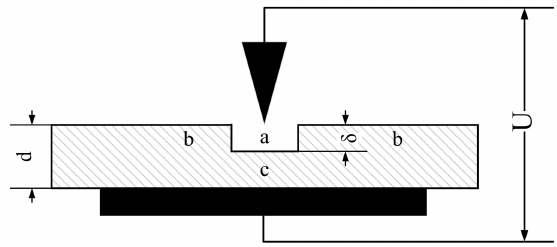
Figure 19. Diagram of the needle-plane defect in oil-paper insulation.